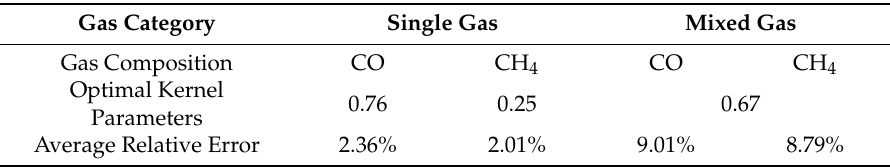
Table 4. Binary mixed gas concentration estimation